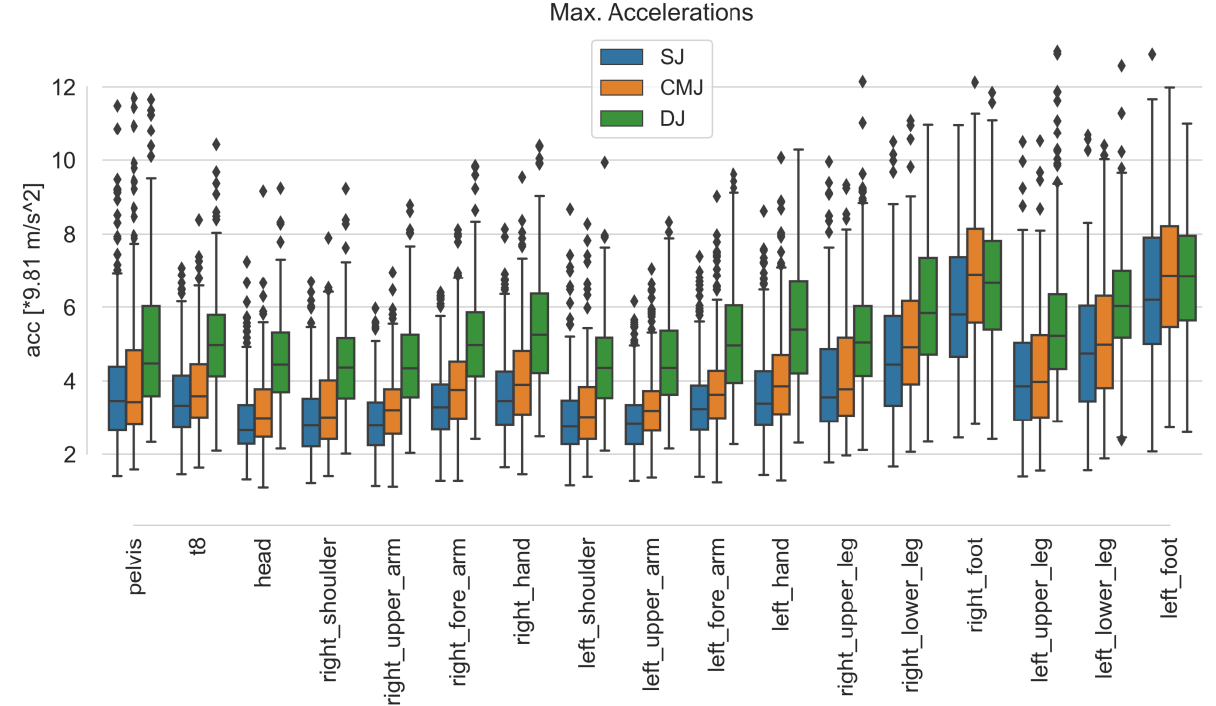
Figure 2. Acceleration curves of all 17 sensors during the jumping exercises, illustrated on a single subject for the third trial each. The acceleration is given as a multiple of the acceleration due to gravity.